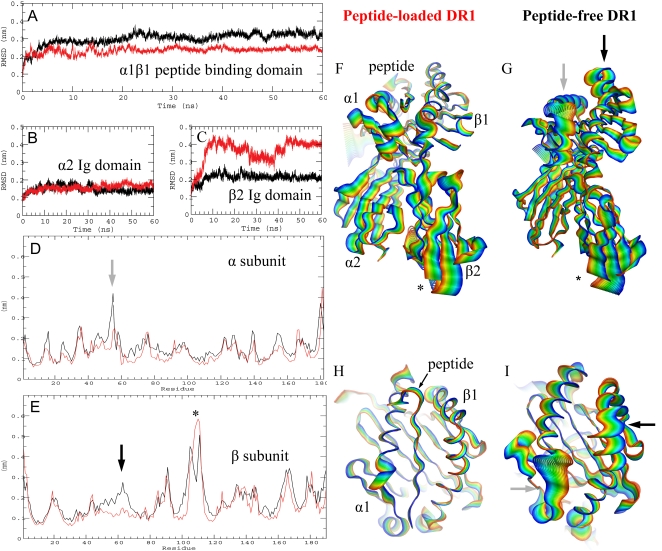
Molecular dynamics simulation of peptide-bound and peptide-free DR1.A, (A–C) RMS deviation over time for the peptide-loaded (red) and peptide-free (black) simulations, for the α1β1 peptide-binding domain (A), the Ig-like α2 domain (B), and the Ig-like β2 domain (C). D–E, Root mean square (RMS) fluctuation during the simulation for each residue (all atoms included) for the α (D) and β (E) subunits. (F–I) Molecular dynamic trajectories for the peptide-loaded (F,H) and peptide-free (G,I) form of DR1. Initial states shown in blue, final states shown in red, with a linear interpolation of conformations between the initial and final structures shown in other colors. (F,G), Side view of entire protein, (H,I) Top view of peptide binding site only.